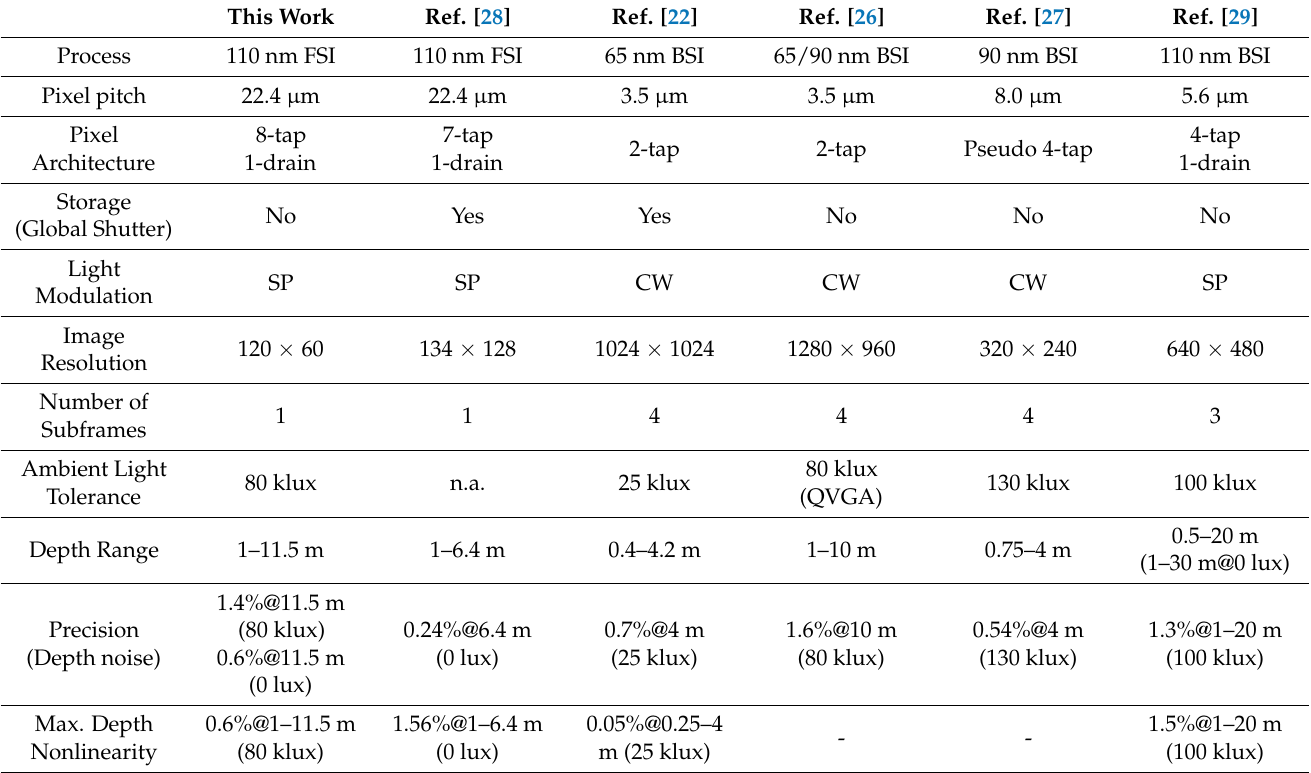
Table 2. Comparison of specifications and